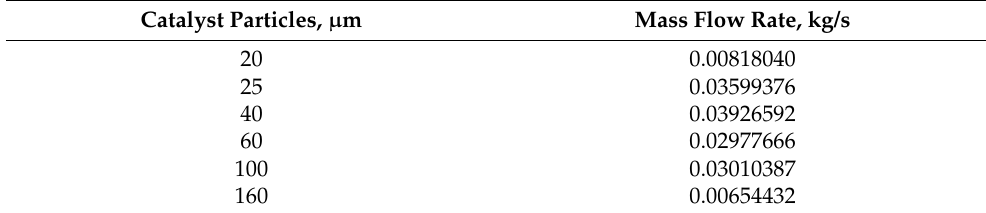
Table 1. Mass flow rate of catalyst particles.